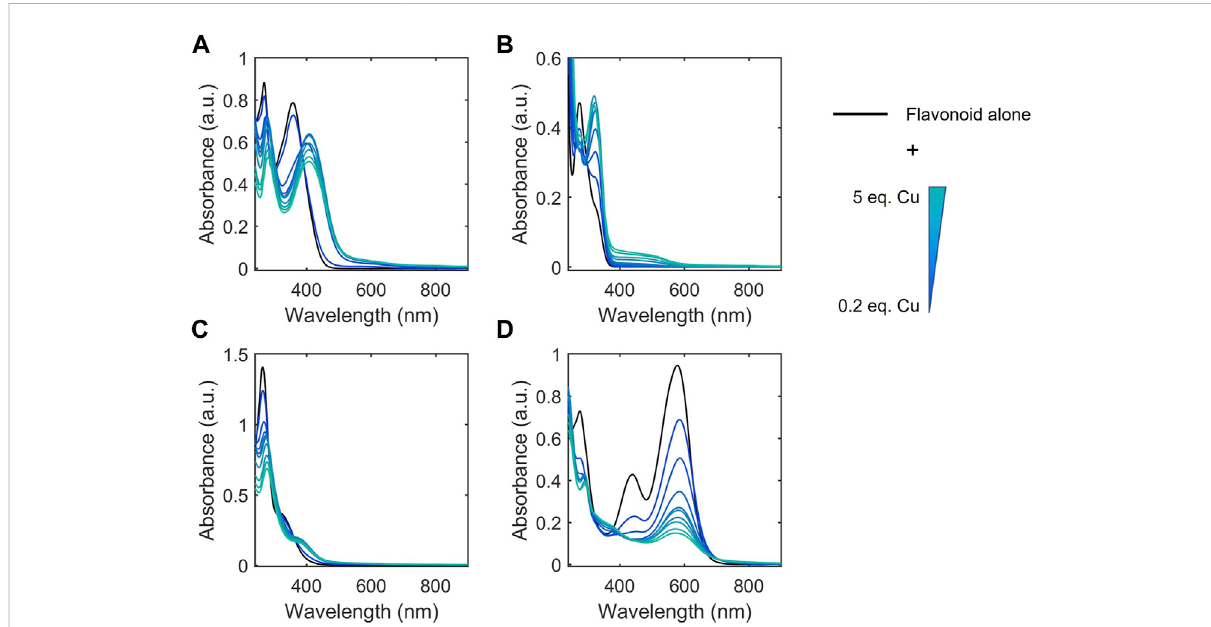
FIGURE 2 Electronicabsorptionspectraofrepresentative fl avonoids (A) luteolin, (B) EGCG, (C) biochaninA,and (D) cyanidin(black)in50 mMMOPSbuffer (pH 7.4) titrated with CuSO 4 . Flavonoids were prepared at 50 µM and CuSO 4 was titrated into the solution from 0.2 to 5 molar equivalences. Flavonoids typically have two distinct absorption bands: a strong absorbance between 270 and 295 nm (Band II) and a weak Band I absorbance that appears as a shoulder at slightly longer wavelengths. Changes in the intensities and shifts in the lambda max wavelengths of these bands, indicate interactions of Cu(II) with the fl avonoids. Electronic absorption spectra of the remaining fl avonoids tested are shown in Supplementary Figure